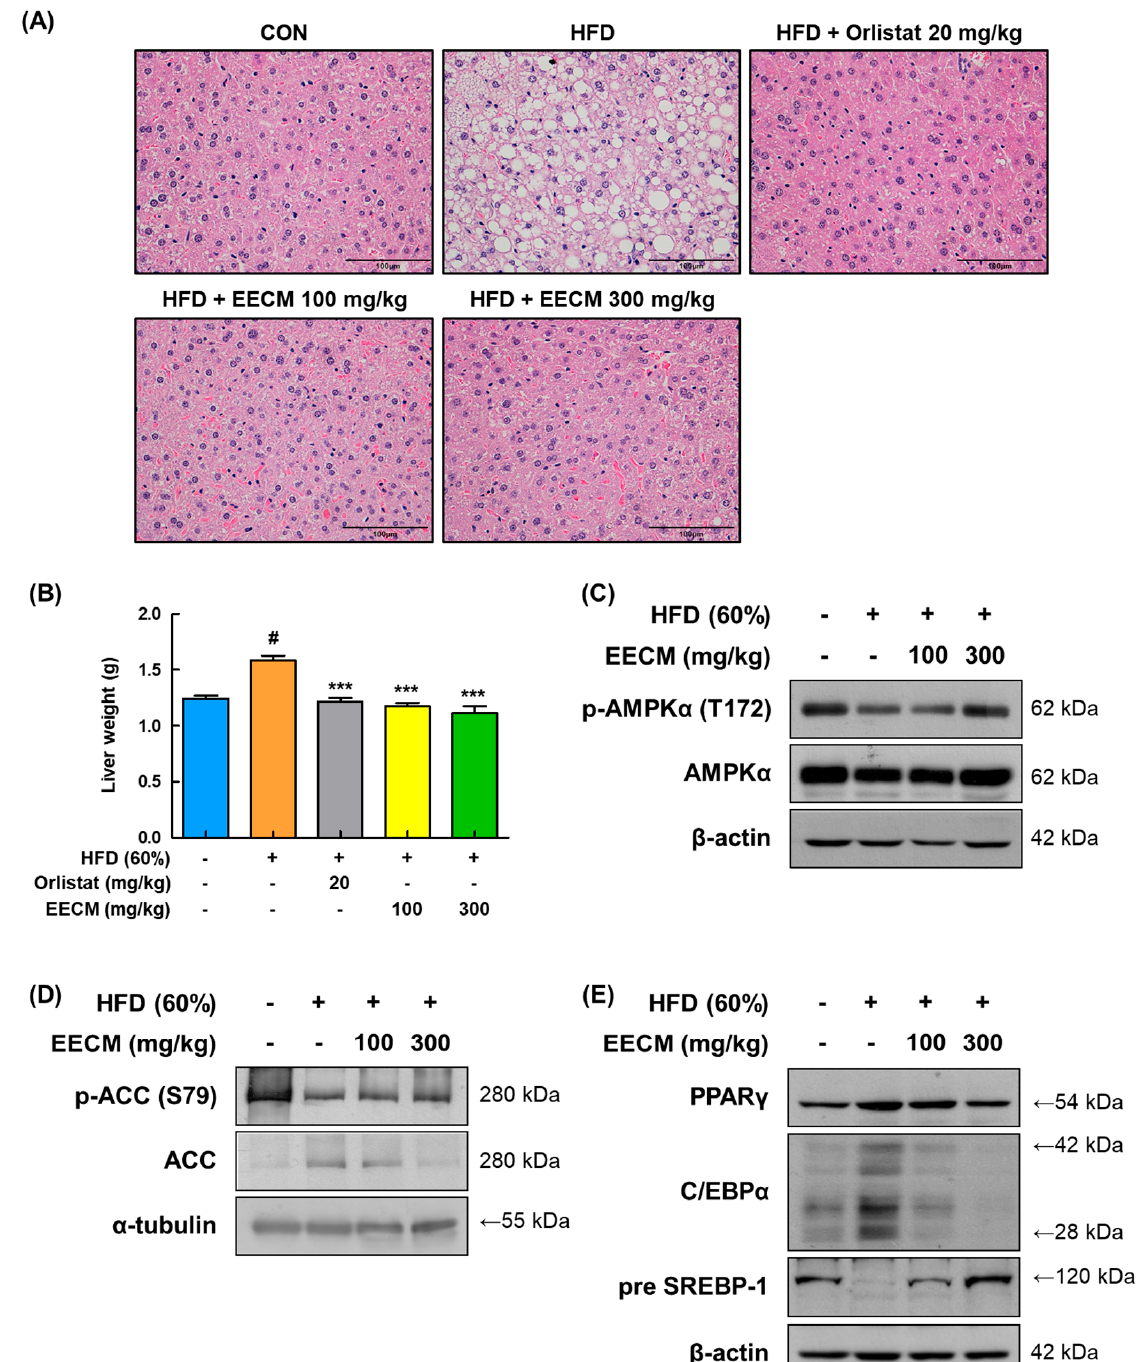
Figure 8. Effect of EECM on lipid accumulation in the liver tissues of HFD (60%)-induced obese mice. ( A ) The images of H&E stained the liver tissues at ×40 magnification. ( B ) Comparison of liver weights of each group. Expression levels of ( C ) p-AMPK α , ( D ) lipogenic proteins, and ( E ) adipogenic transcription factors were determined via Western blotting analysis. Values are represented as the mean ± SEM ( n = 8/group). # p < 0.05 vs. the CON group; *** p < 0.001 vs. the HFD (60%)-induced obese